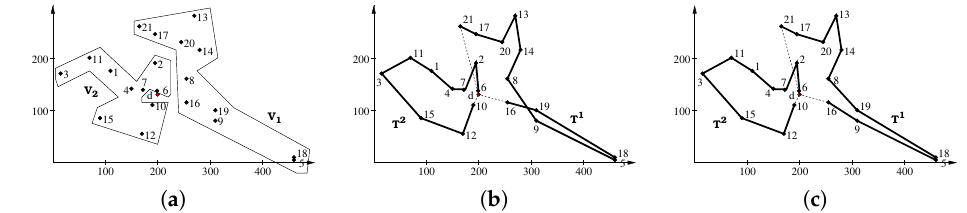
Figure 26. Tours T 1 y T 2 constructed by the bounded multiprocessor TSP method for 2 supervisors, m min = 10 and m max =